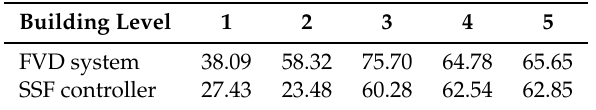
Table 5. Total-acceleration peak-value reductions with respect to the uncontrolled response.